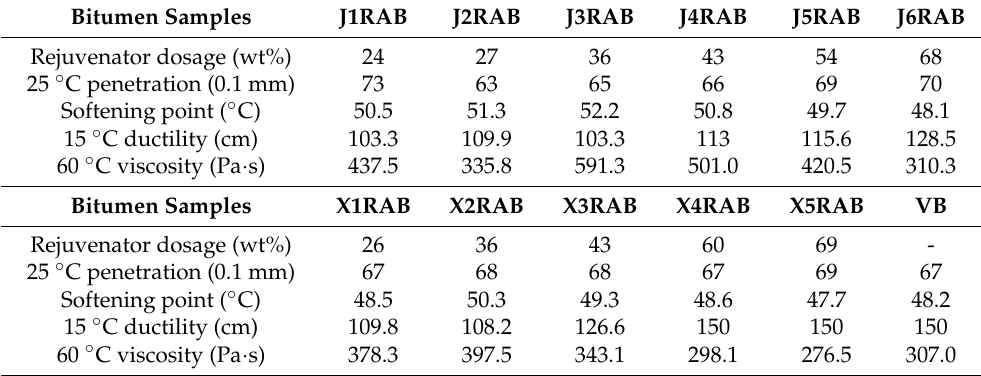
Table 7. Physical properties of virgin and rejuvenated artificial-aged bitumen. Bitumen Samples